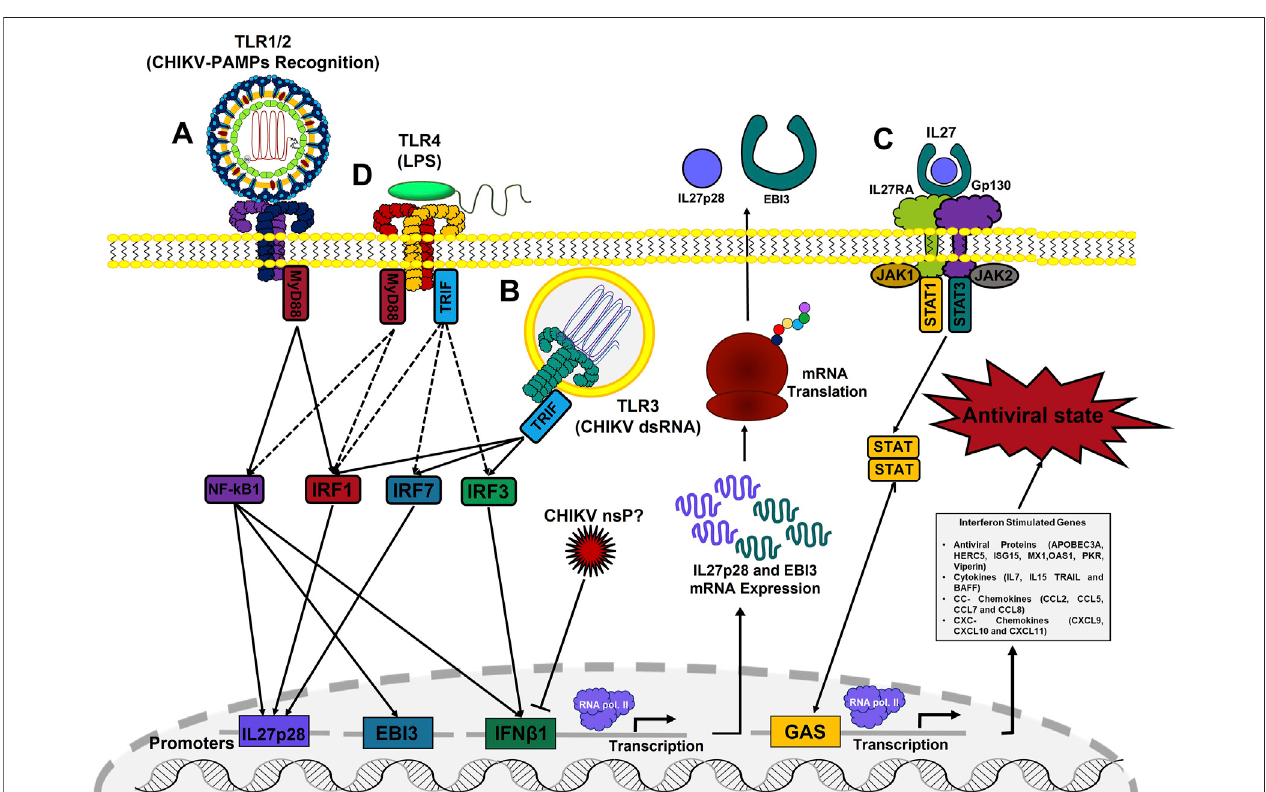
FIGURE 11 | Schematic model of induction of IL27-dependent pro-in fl ammatory and antiviral response in CHIKV-infected MDMs. IL27 production in CHIKV- infected MDMs is dependent on two signaling pathways depending on the TLRs activation. An early signal dependent on recognition of CHIKV-PAMPs by TLR1/2- MyD88 to activate NF- κ B-complex and induce EBI3 mRNA expression (A) ; and a late signal dependent on recognition of intermediates of CHIKV replication by TLR3- TRIF, to activate IRF1 and induces IL27p28 mRNA expression (B) . Both signals are required to produce a functional IL27 protein and activated IL27 signaling pathway involved in the induction of ISGs expression, including AVPs, cytokines, CC- and CXC- chemokines; to control CHIKV replication in human MDMs, in an IFN- independentmanner (C) .Activation ofTLR4,byLPS,inducesahighexpression ofboth IL27subunitsinhumanMDMsandmurineBMDM and activatedrobustSTAT1- dependent pro-in fl ammatory and antiviral response in an IL27-dependent manner (D) .